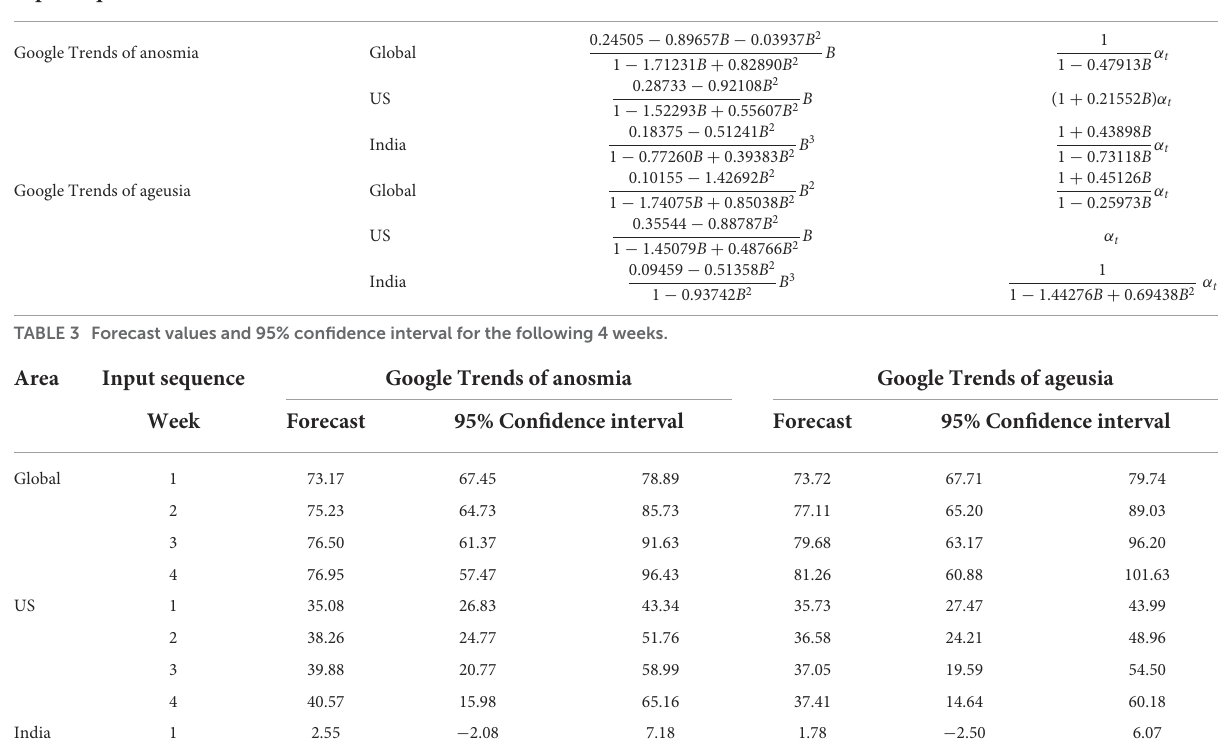
TABLE 2 Transfer function models for different areas and different input sequences.